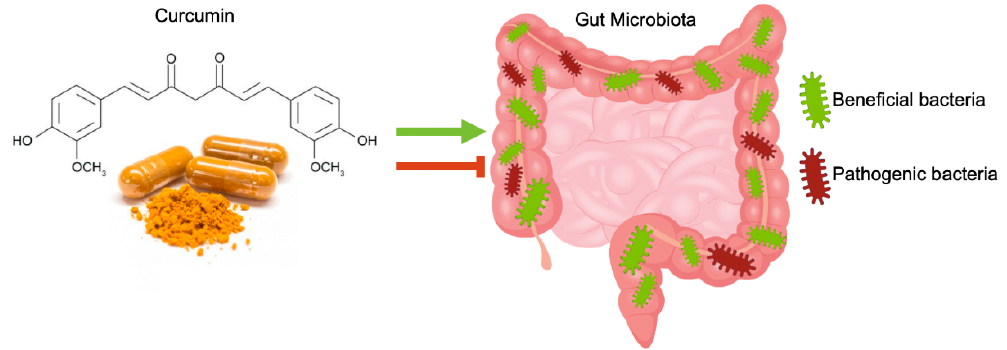
Figure 2. Schematic illustration of the interactions between curcumin and gut microbiota. The administration of curcumin considerably changed the ratio between beneficial and pathogenic bacteria in a gut microbiota community, favoring the growth of beneficial bacteria and limiting the growth of pathogenic ones.